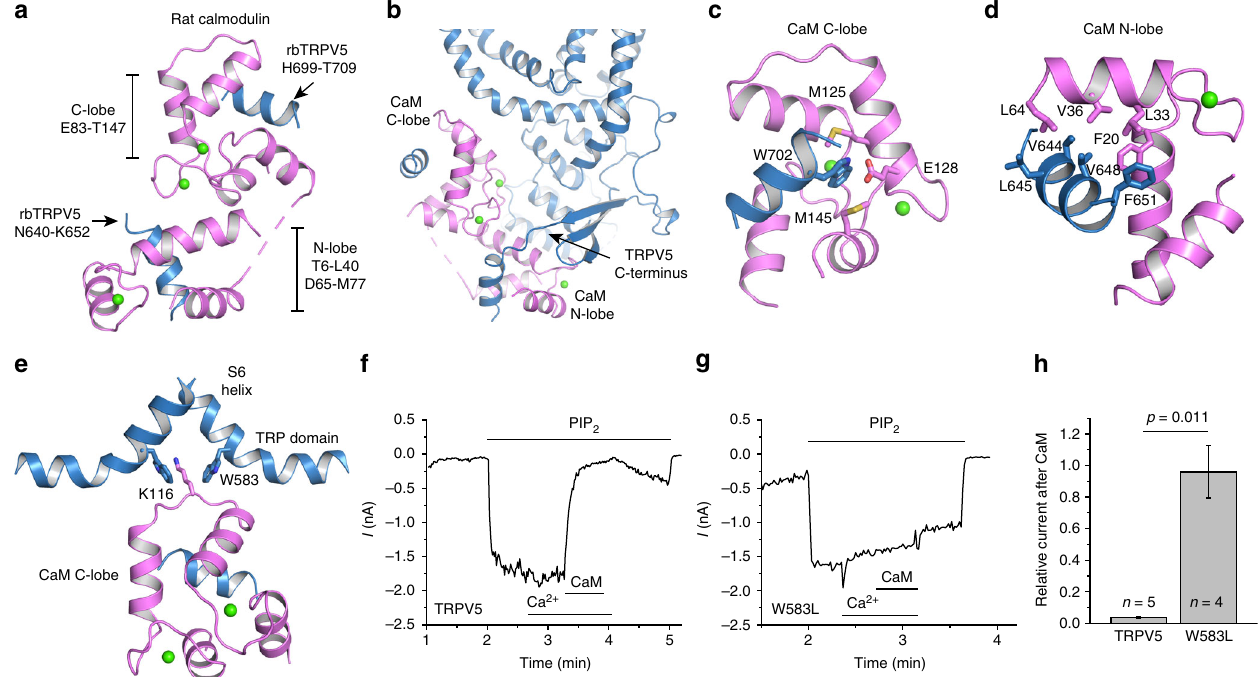
Fig. 6 Mechanism of TRPV5 inactivation by CaM. a Structure of rat CaM bound to TRPV5 C-terminus fragments. Both the N-lobe and C-lobe were visualized along with N640-K652 and H699-T709 of TRPV5. CaM is shown in hot pink, and TRPV5 is shown in blue. Calcium ions bound to the N-lobes and C-lobes of CaM are shown as green spheres. b CaM interaction with chain A of TRPV5. c CaM C-lobe interaction with W702 on the TRPV5 C-terminus. d CaM N-lobe makes multiple hydrophobic interactions along N640-K652. e The base of the TRPV5 pore is shown with K116 of CaM bound at W583, causing a steric blockage of calcium fl ow. f The excised inside out patch clamp experiments show that wild type TRPV5 is inhibited upon addition of Ca 2 + activated CaM. Representative current trace is at − 100 mV; the applications of 25 μ M diC 8 PI(4,5)P 2 , 0.2 μ M CaM and 3 μ M free Ca 2 + are indicated by the horizontal lines. g The excised inside out patch clamp experiments show that Ca 2 + -activated CaM did not inhibit the W583L TRPV5 mutant. Representative current trace is at − 100 mV; the applications of 25 μ M diC 8 PI(4,5)P 2 , 0.2 μ M CaM and 3 μ M free Ca 2 + are indicated by the horizontal lines. h Summary of the data, current amplitudes after CaM were divided by current values before CaM applications, P = 0.011 (two-sample t -test). The sample size ( n ) indicates the number of individual patches tested, each obtained from a different oocyte. Error bars represent